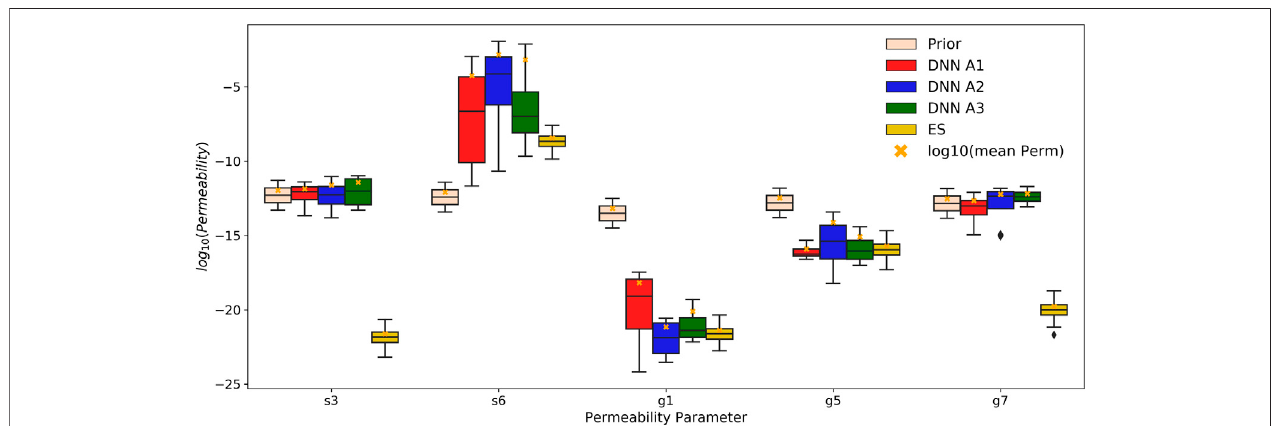
FIGURE 10 | Permeability estimations from the observed discharges from the DNNs and the ES using relative observation error of 0.05. The peach-colored boxplots are the prior distributions for each permeability parameter. The gold-colored boxplots are the distribution of permeability estimations from the ES. Each of the remaining colored boxplots is the corresponding distributions of DNN estimations. The orange crosses are the log 10 -transformed mean permeability value for the corresponding distribution.